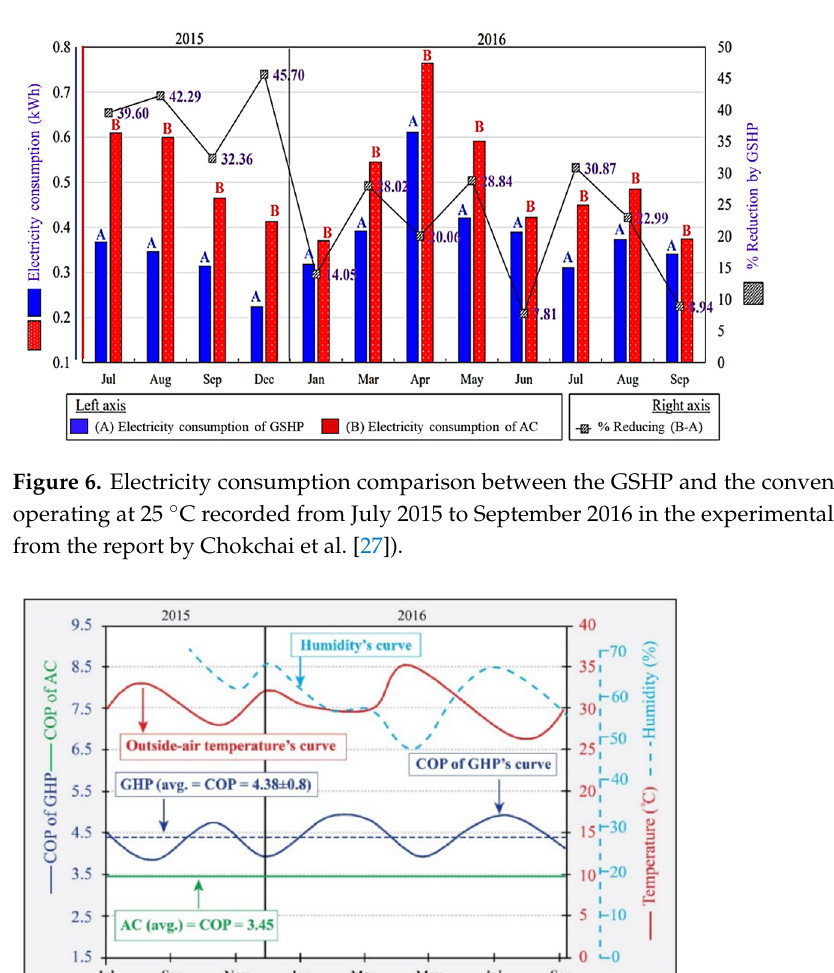
Figure 5. Installation of the GSHP connected to the second floor of the Parot Racha building, Bangkok, Thailand (obtained from the report by Chokchai et al. [27]).